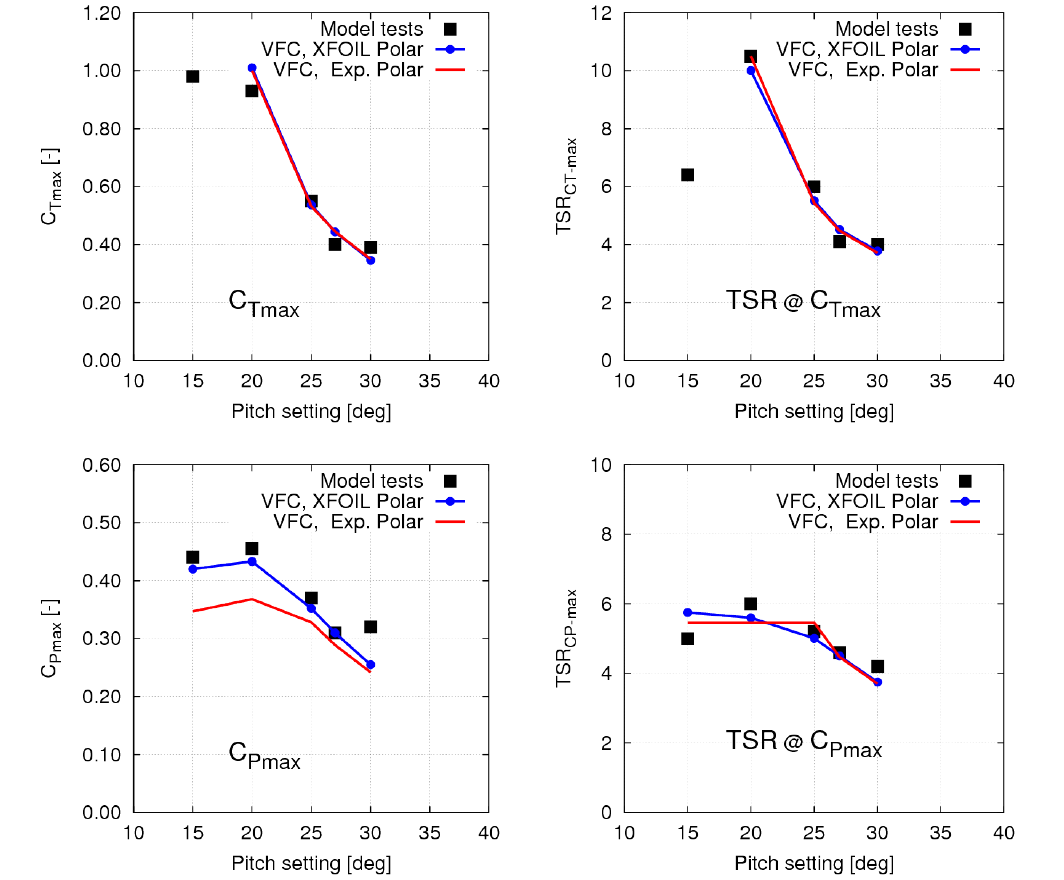
Figure 27. UoS-VP turbine. Effect of pitch setting Φ : from top to bottom , left to right , C corresponding TSR values TSR@ C